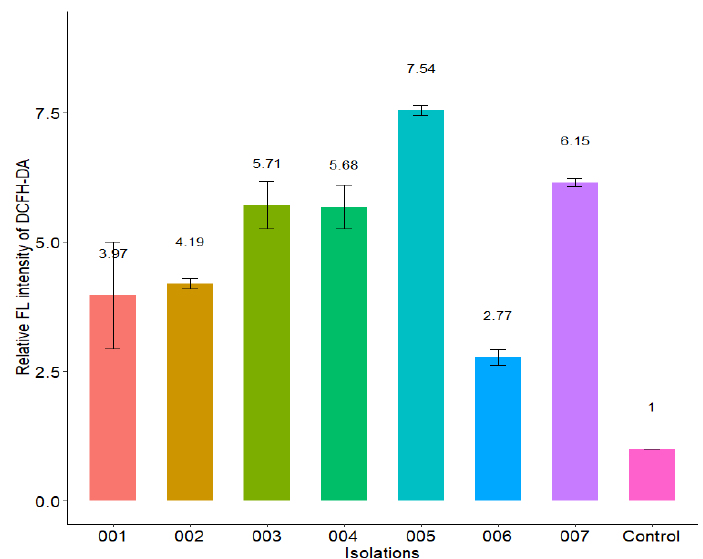
Figure 11. Effect of ISO treatment on iROS production in C. tropicalis . The relative fluorescence intensity of the isolates treated with the ISO MIC for each one was compared with that of the control group (untreated cells).